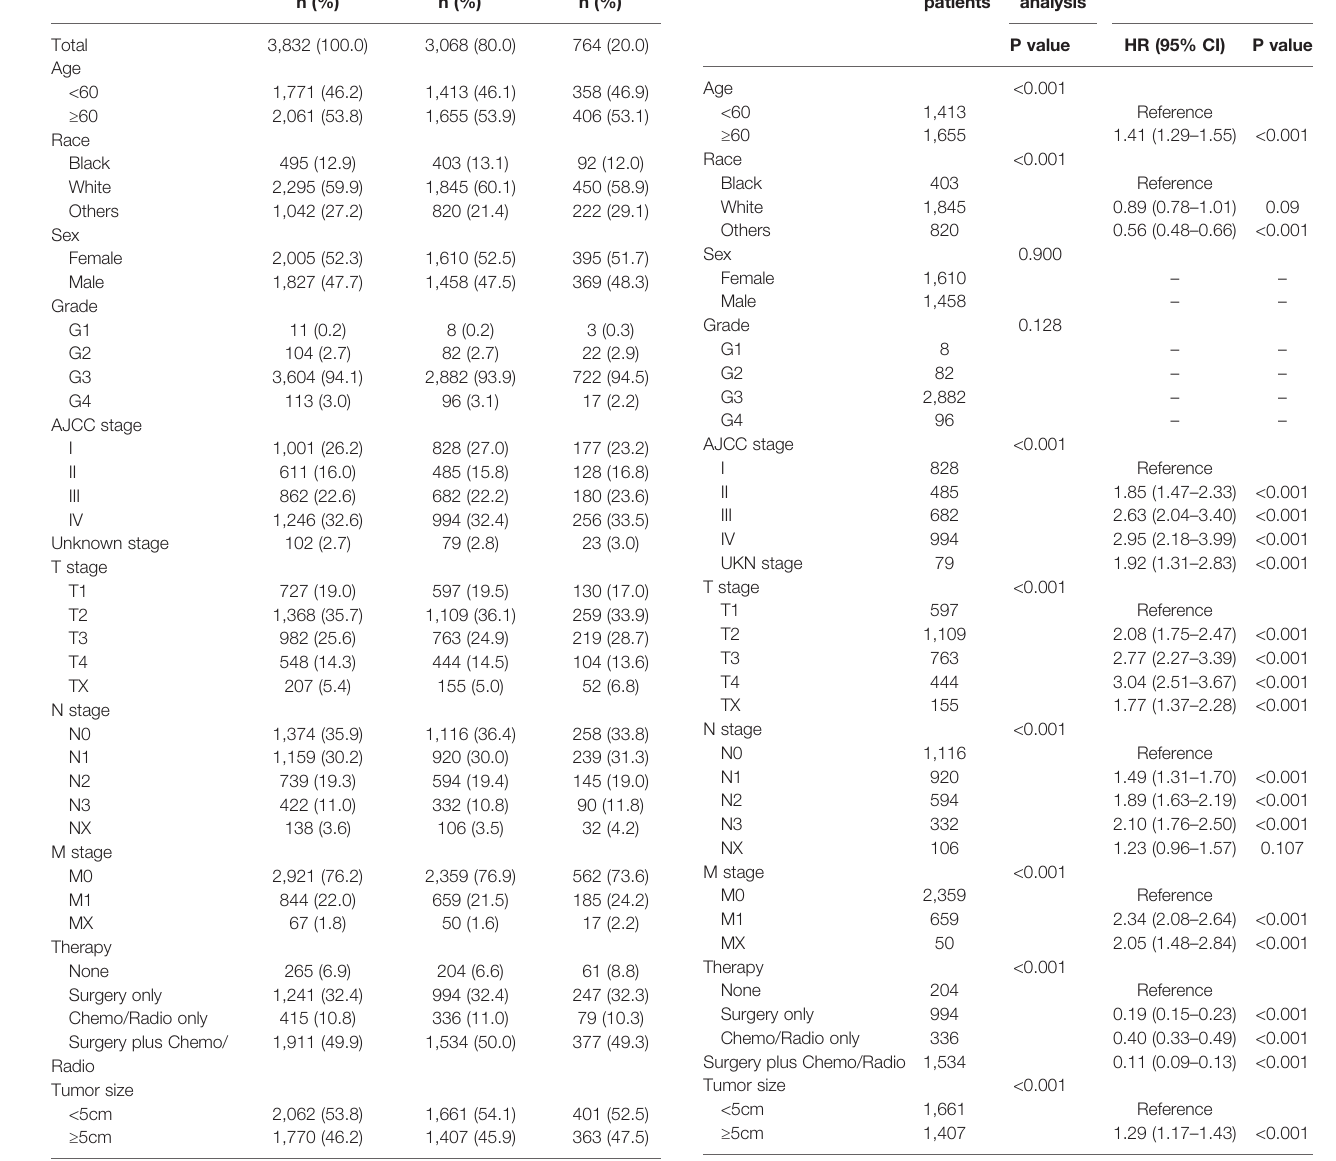
TABLE 2 | Risk factors affecting patients ’ overall survival (OS), according to the univariate and multivariate Cox analysis. Variables